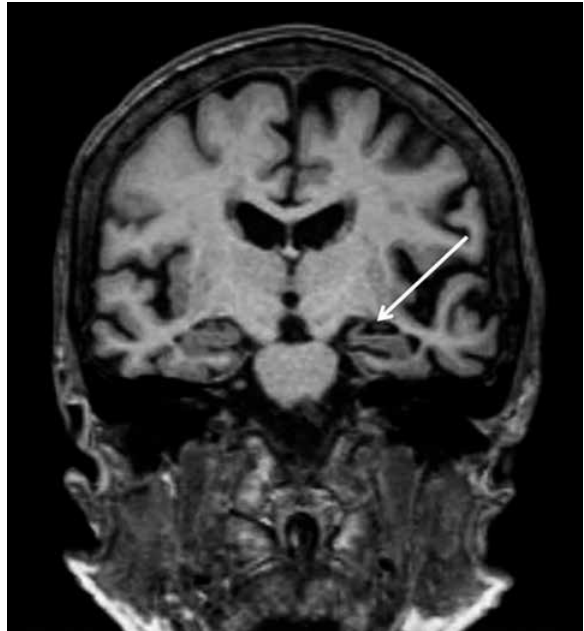
Figure 2. Coronal FLAIR brain MRI image. Image reveals bilateral hippo- campal reduction predominantly to the